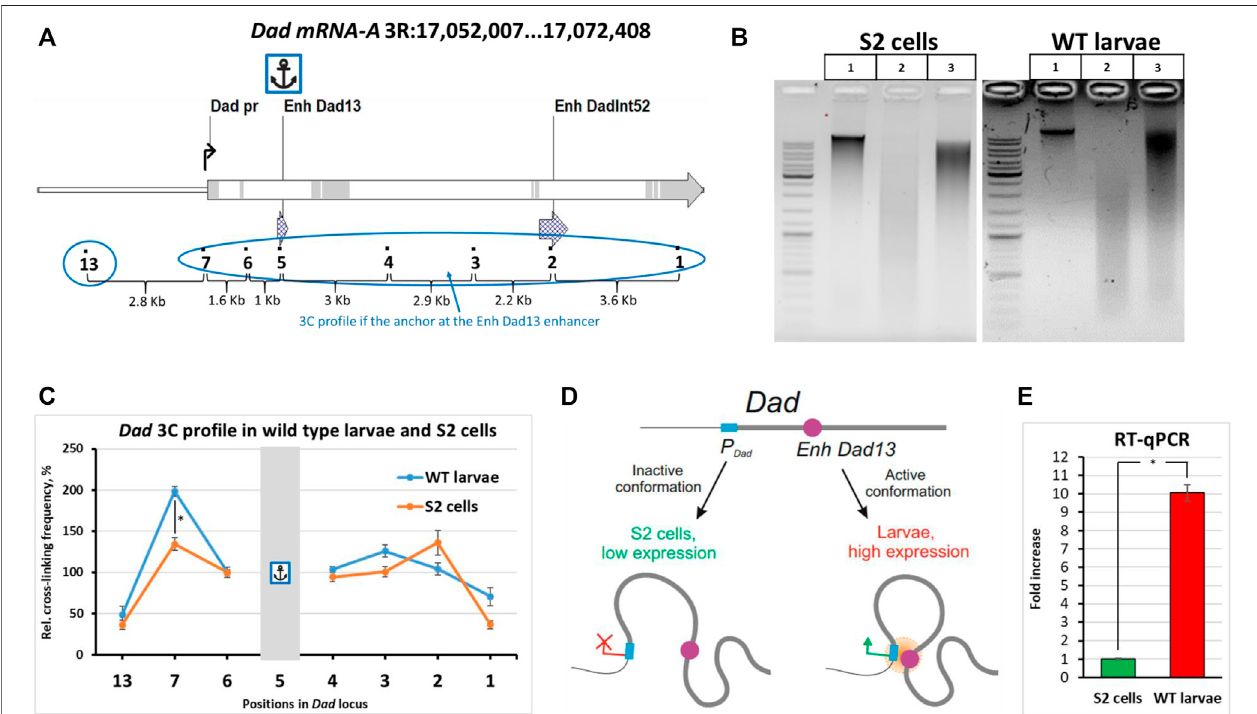
FIGURE 2 | Comparison of the 3C pro fi les of live wild-type Drosophila larvae and S2 cells. (A) The model locus Dad with an anchor on the enhancer Dad13 in WT Drosophila larvae and S2 cells is shown. Designations are as shown in Supplementary Figures S3A . Exons are highlighted grey; introns are shown white. (B) A representative example of the 3C libraries prepared from WT larvae and S2 cells. Larvae were extracted from fl y food, as shown in Figure 1B . One hundred WT larvae were individually collected and washed, as shown in Figure 1D , and then processed to obtain a cell material, as shown in Figure 1B . Larval cell material (25 mg) wastakenfor3Clibrarypreparation.Thecellmaterialwascentrifuged,thesupernatantwasremoved,anda3Clibraryandcontrols#1and2werepreparedasdescribed in Protocol of the 3C experiment with Drosophila larvae in the Supplementary Material . The 3C libraries and controls of S2 cells were prepared as shown in SupplementaryFigureS6 exceptthatcontrol#1andtheligationmixturewerepuri fi edusinga1.5XvolumeofAMPureXPbeadsandcontrol#2waspuri fi edusinga2X volume of AMPure XP beads. For electrophoresis, in the case of S2 cells, 200 ng of DNA was used for controls #1,2 and the ligation mixture. In the case of larvae, the DNA amount resolved in the gel was 25 ng for control #1, 50 ng for control #2, and 75 ng for the ligation mixture. Lane 1, control #1 (chromatin integrity control); lane